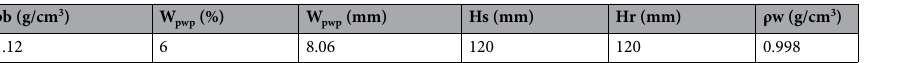
Table 2. Test soil and plant information. ρb, soil bulk density; W pwp , permanent wilting point; Hs, average soil depth; Hr, root length; Ρw, water density (at 20 °C).